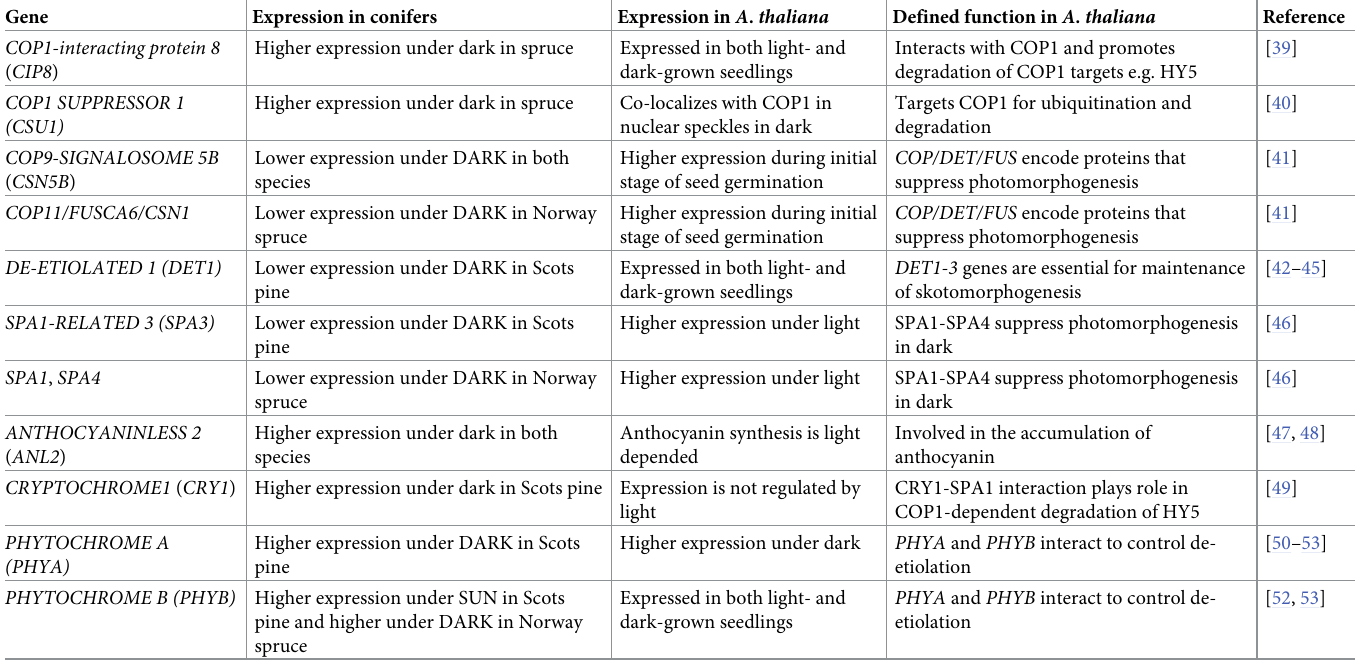
Table 1. Candidate genes associated with photomorphogenesis in conifers, with defined functions in A . thaliana